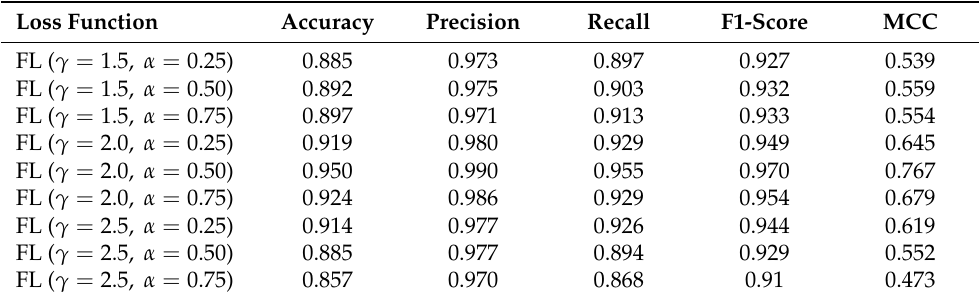
Table 5. Classification results with HSI-90 dataset for varying cost functions and respective parameter sets. (patch size parameter S = 100, 3D convolutions, see Figure A2 for network topology).